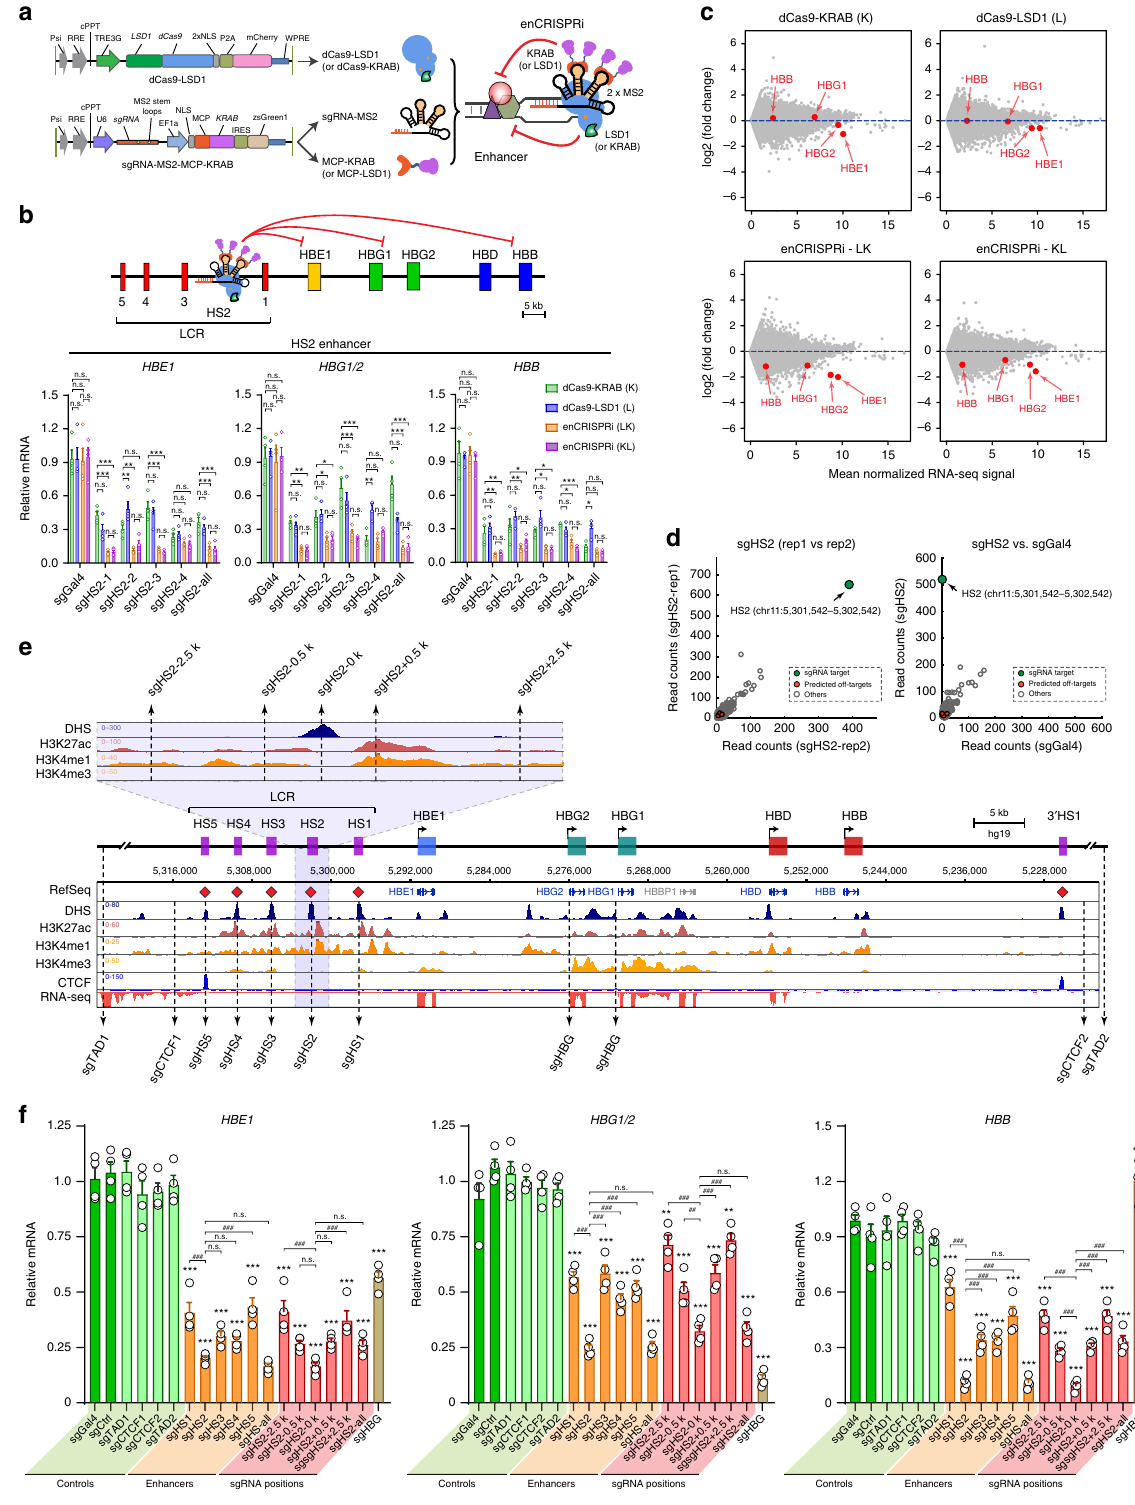
sgRNAs (sgHS2-1 to sgHS2-4) relative to nontargeting sgGal4 (Fig. 2b). We further engineered the second version of enCRISPRi using dCas9-KRAB + MCP-LSD1 (enCRISPRi-KL) combination (Fig. 2a; Supplementary Fig. 1a). Targeting of either enCRISPRi complex to the HS2 enhancer by four independent sgRNAs achieved comparable and signi fi cant repression of β -globin